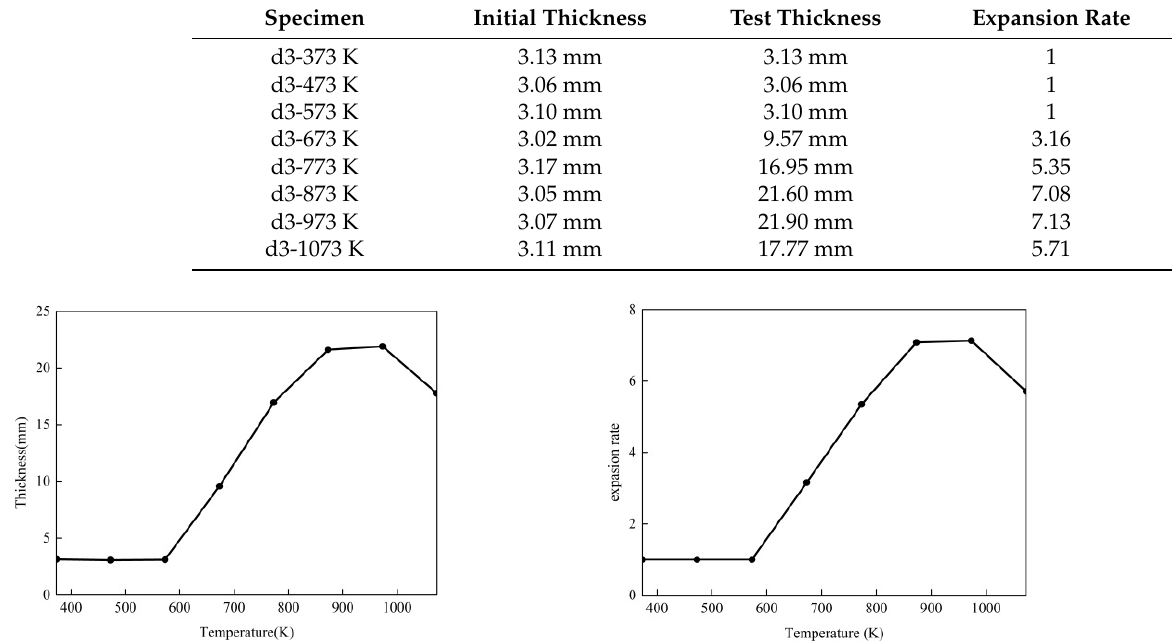
Figure 3. Thickness and expansion rate variation with temperature.